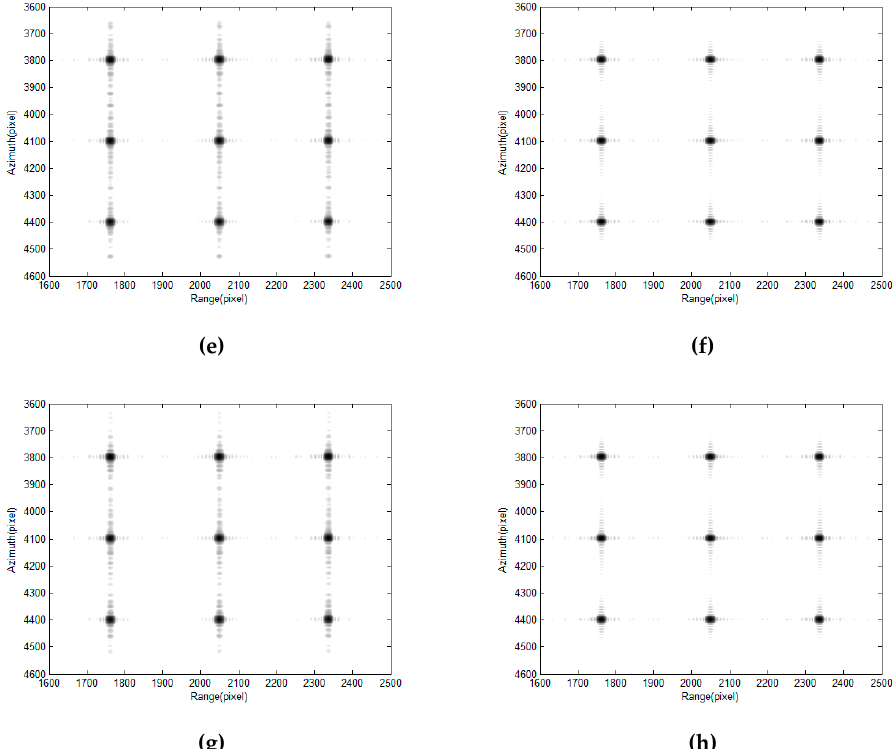
Figure 5. Imaging simulation result. ( a ) Image with no interference; ( b ) Before interference cancellation; ( c ) Result of conventional STAP (M = 16); ( d ) Result of PC-STAP (M = 16); ( e ) Result of conventional STAP (M = 32); ( f ) Result of PC-STAP (M = 32); ( g ) Result of conventional STAP (M = 64); ( h ) Result of PC-STAP (M = 64).